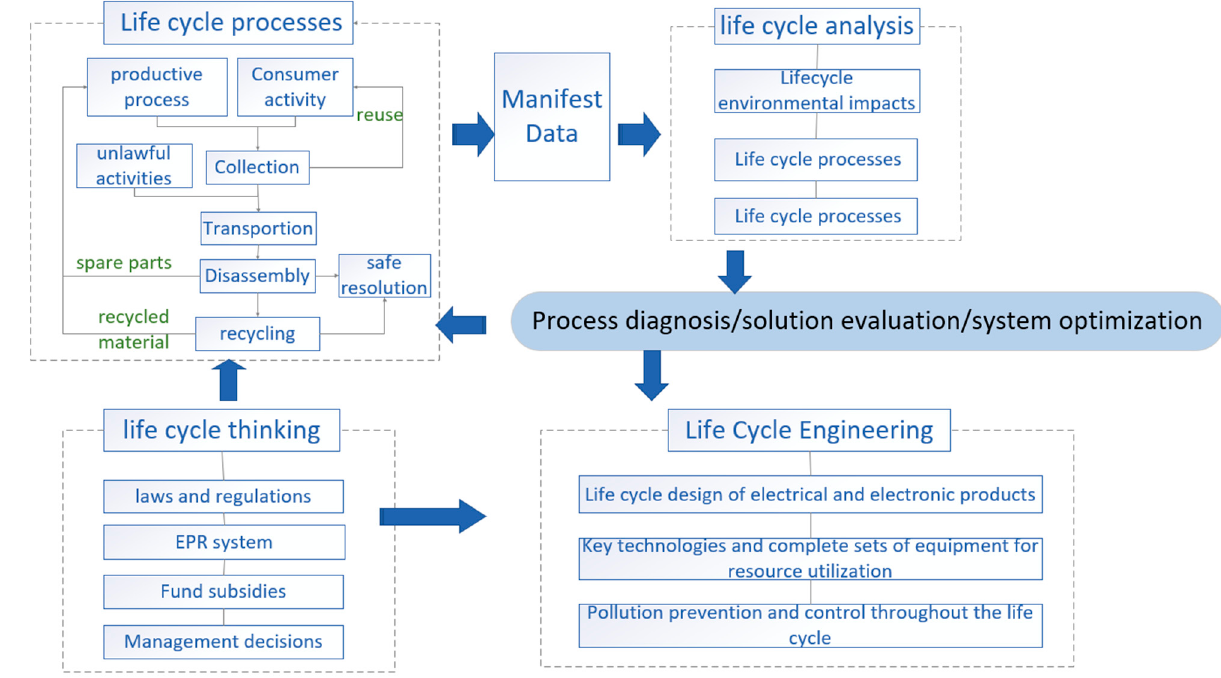
Figure 12. WEEE lifecycle management system framework.